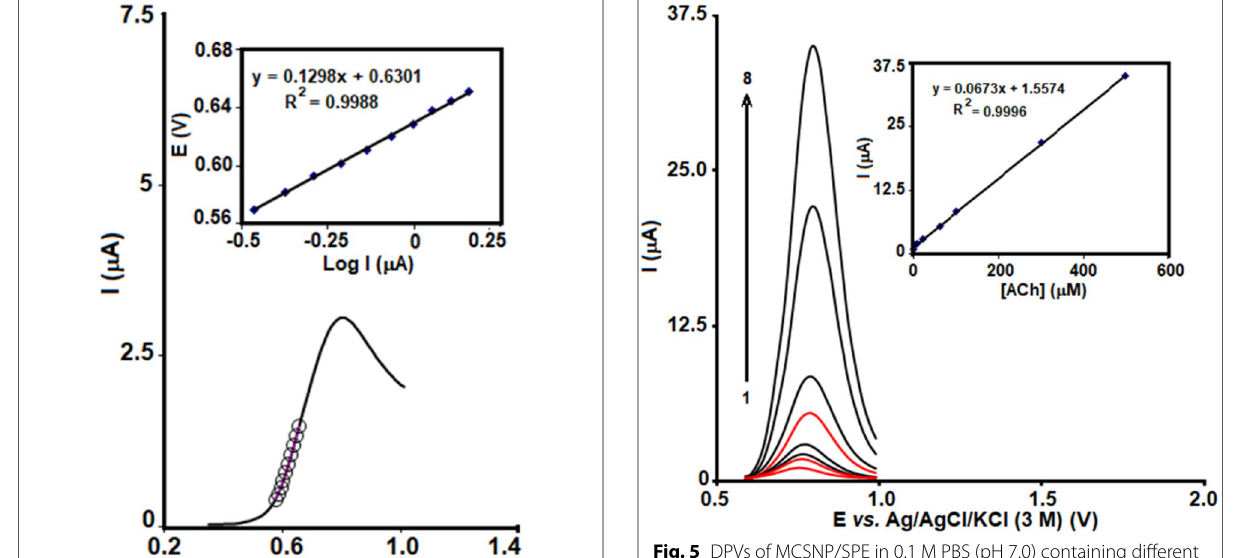
Fig. 5 DPVs of MCSNP/SPE in 0.1 M PBS (pH 7.0) containing different concentrations of ACh (0.1, 2.5, 8.0, 20.0, 60.0, 100.0, 300.0